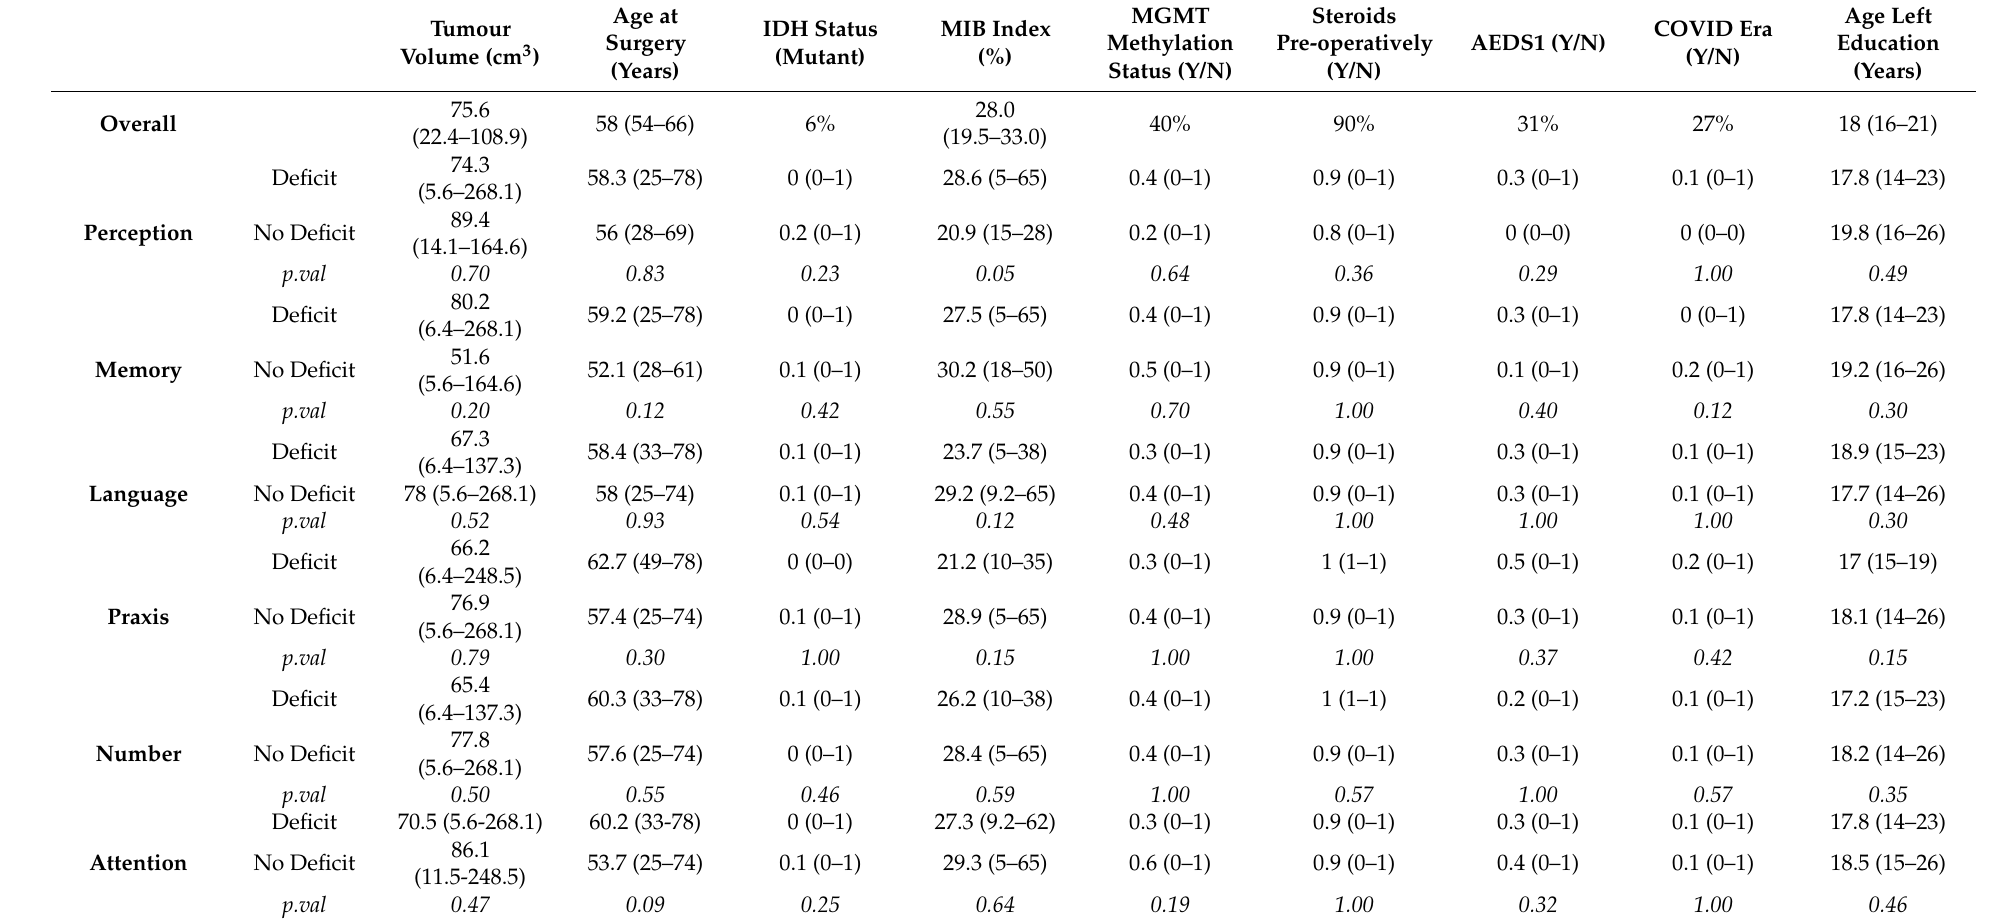
Table 1. Multivariate regression model of the association between each characteristic and cognitive deficit at